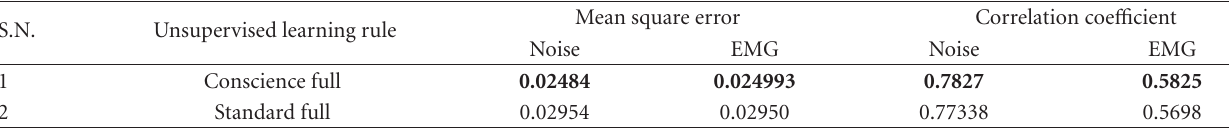
Table 10: Selection of unsupervised learning rule for RBF NN model.